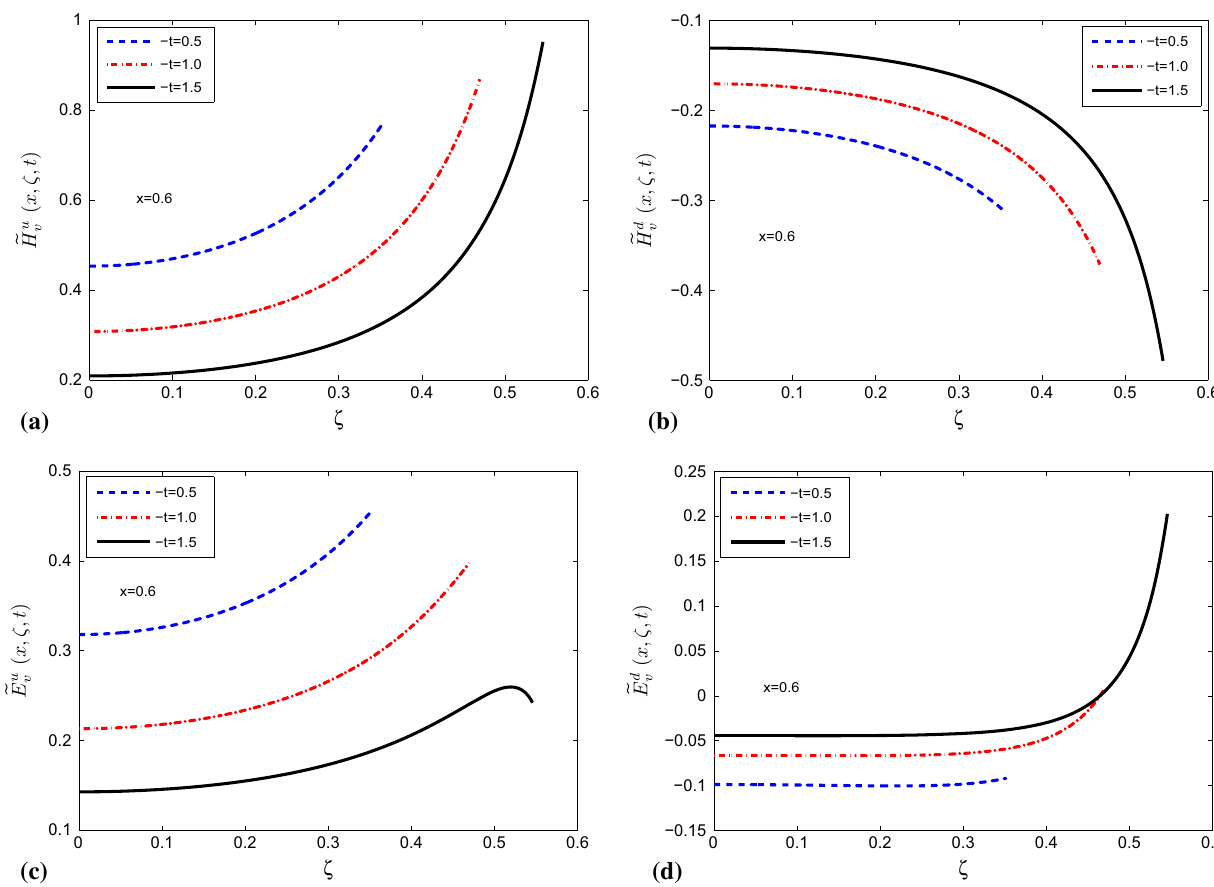
Fig. 3 (Color online) Plots of helicity-dependent GPDs for the nonzero skewness vs. ζ and different values of − t in GeV 2 , for a fixed value of x = 0 . 6. The left panel is for the u quark and the right panel is for the d quark